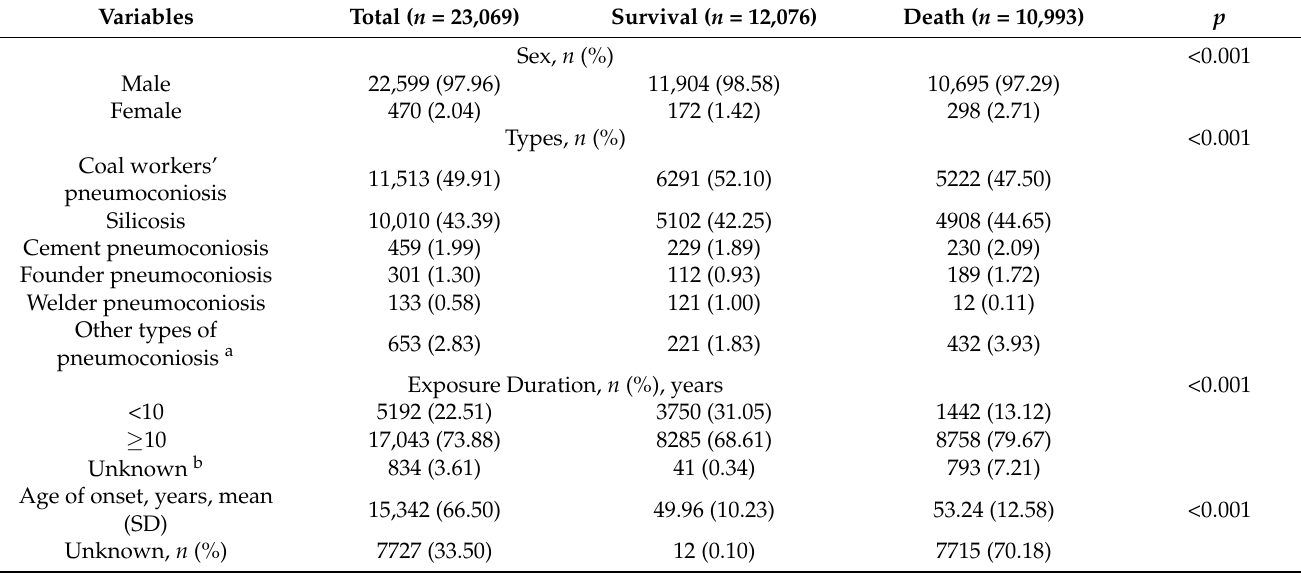
Table 4. Characteristics information in Dead and Survival Pneumoconiosis Patients in Hubei,